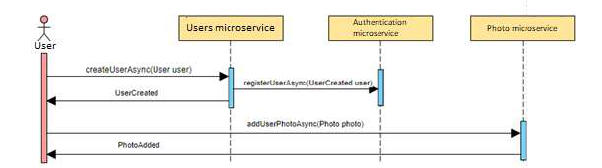
Figure 3. Sequential diagram of adding a new